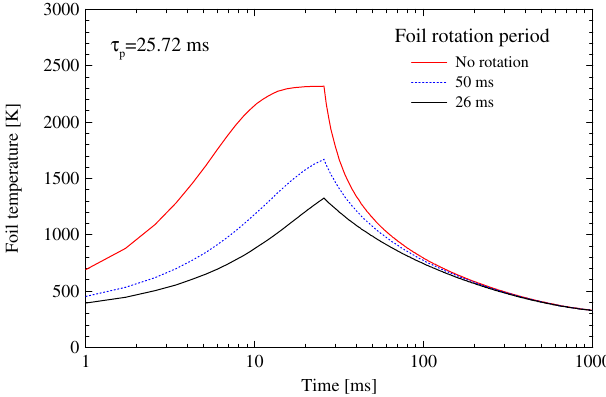
FIG. 9. Calculated temperature distributions during an injec- tion cycle for several painting cycle durations, (cid:10) p (see Table II). The temperatures are given at the hottest spot of the 600 - (cid:3) g = cm 2 corner carbon foil irradiated with an 8-GeV proton beam at normal incidence.